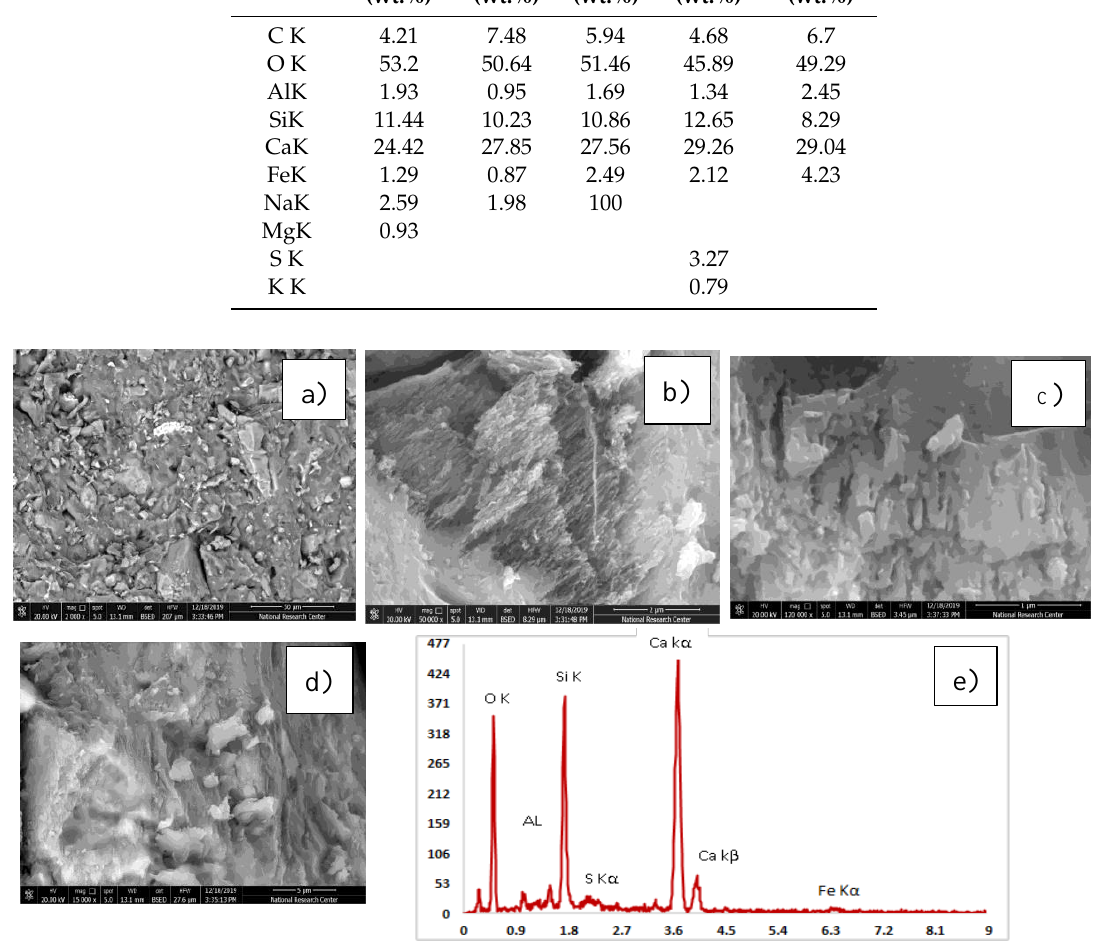
Figure 12. ( a – d ) SEM images at different magnification factor and ( e ) EDX for the control mix of UHPC.